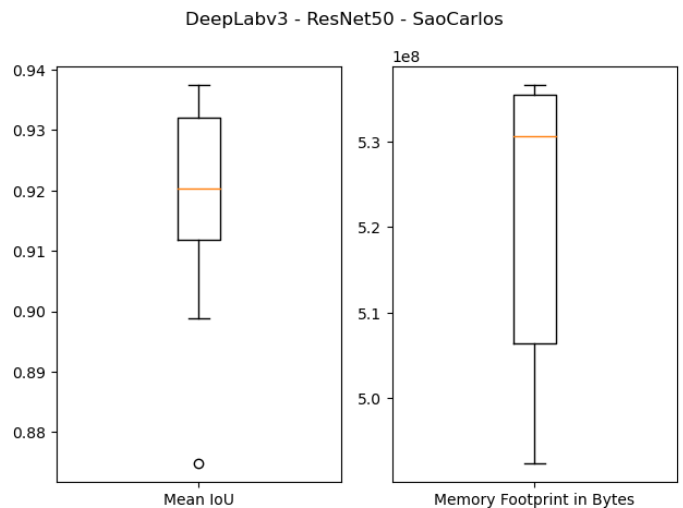
Figure 11. Boxplot results for the São Carlos Rivers dataset using the ResNet50 Bhckbone and 512 MB of desired memory footprint.